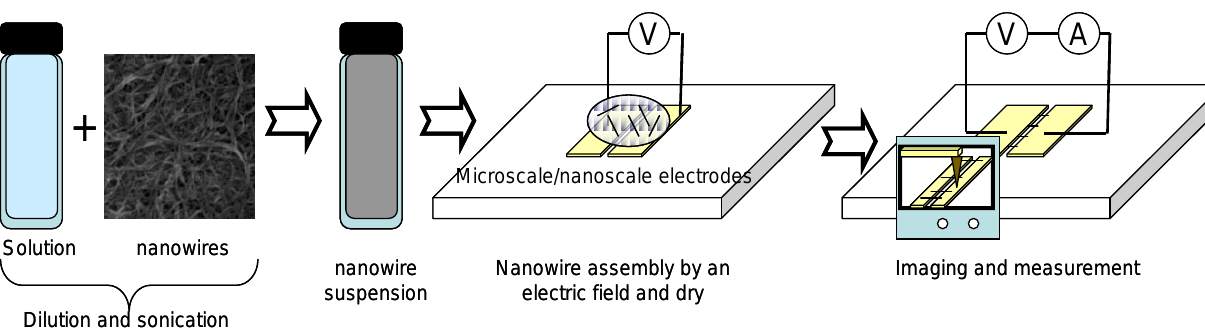
Figure 1. Conventional process of parallel assembly for nanowires using an electric